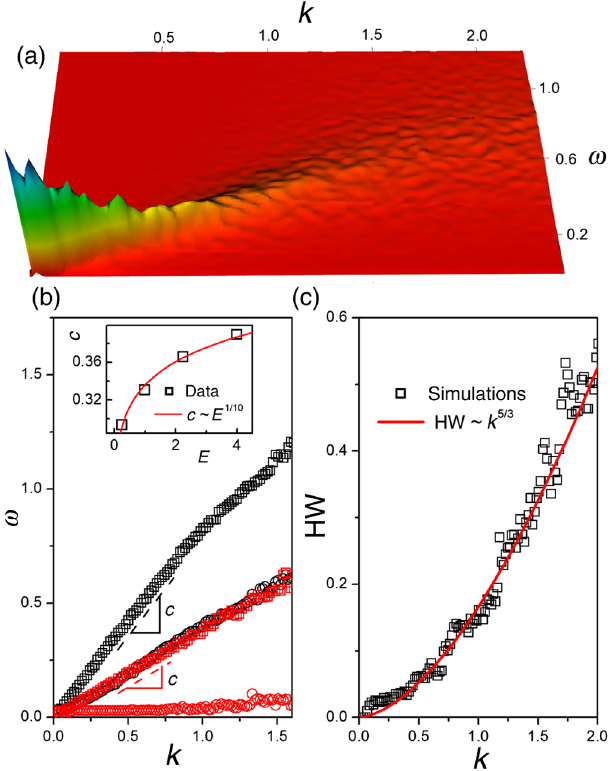
FIG. 5. (a) The power-spectral density for longitudinal modes that emerge in marginally compressed amorphous packings ( P ∼ 10 − 6 ) by the complete disintegration of an initial solitary- wave excitation. (b) The red squares show the numerical data for the longitudinal dispersion curves. The slope of the linear regime scales with the energy of the solitary wave as c ∼ E 1 = 10 for a Hertzian interaction that we identify with long-wavelength longitudinal hydrodynamical modes. In con- trast, the red circles show the numerically obtained data for the transverse dispersion curve, where no linear regime is seen. The shear mode is therefore nonpropagating. For com- parison, shown are linear dispersion curves for longitudinal (black squares) and transverse (black circles) dispersion curves obtained for highly compressed jammed packings, prepared at a pressure P ∼ 10 − 1 . In the inset, the speed of sound c determined numerically for different E is plotted as black squares, while the continuous red line is the scaling prediction E ∼ E 1 = 10 . (c) The half-width obtained numerically from the longitudinal modes as a function of wave number on a linear scale and compared against the analytical estimates HW ∼ k 5 = 3 (solid red